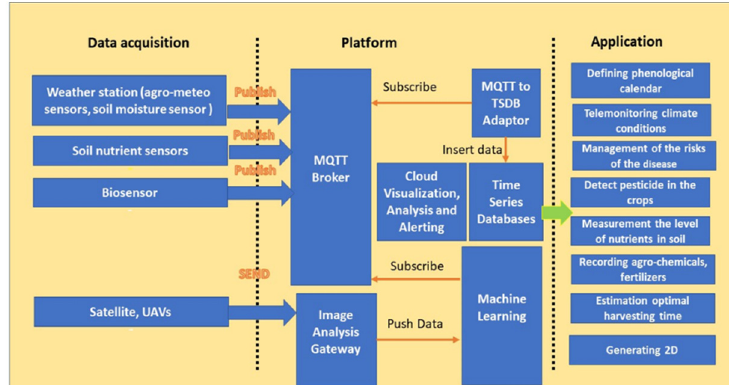
Figure 22. Smart Agriculture platform.